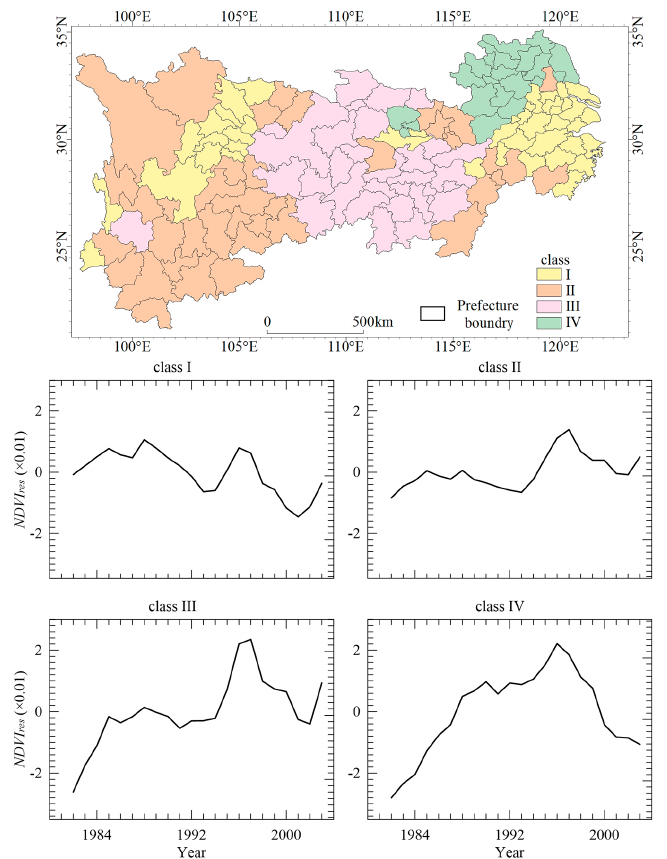
Figure 9. Spatial pattern of NDVI res serials classification (above) and temporal variations of NDVI res of each class (below) from 1982 to 2003.